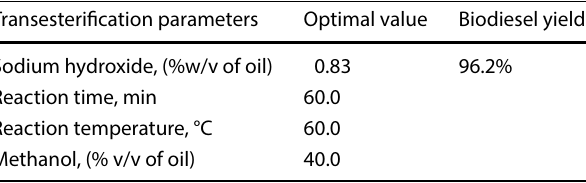
Table 2 Optimal biodiesel yield from transesterification process Transesterification parameters Optimal value